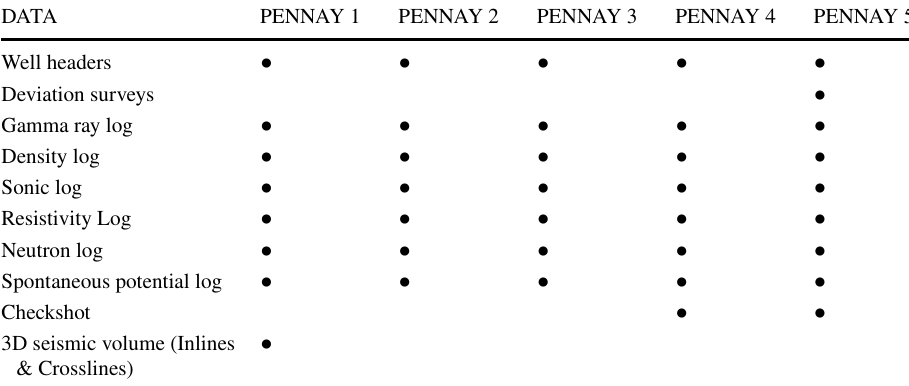
Table 1 Data available for